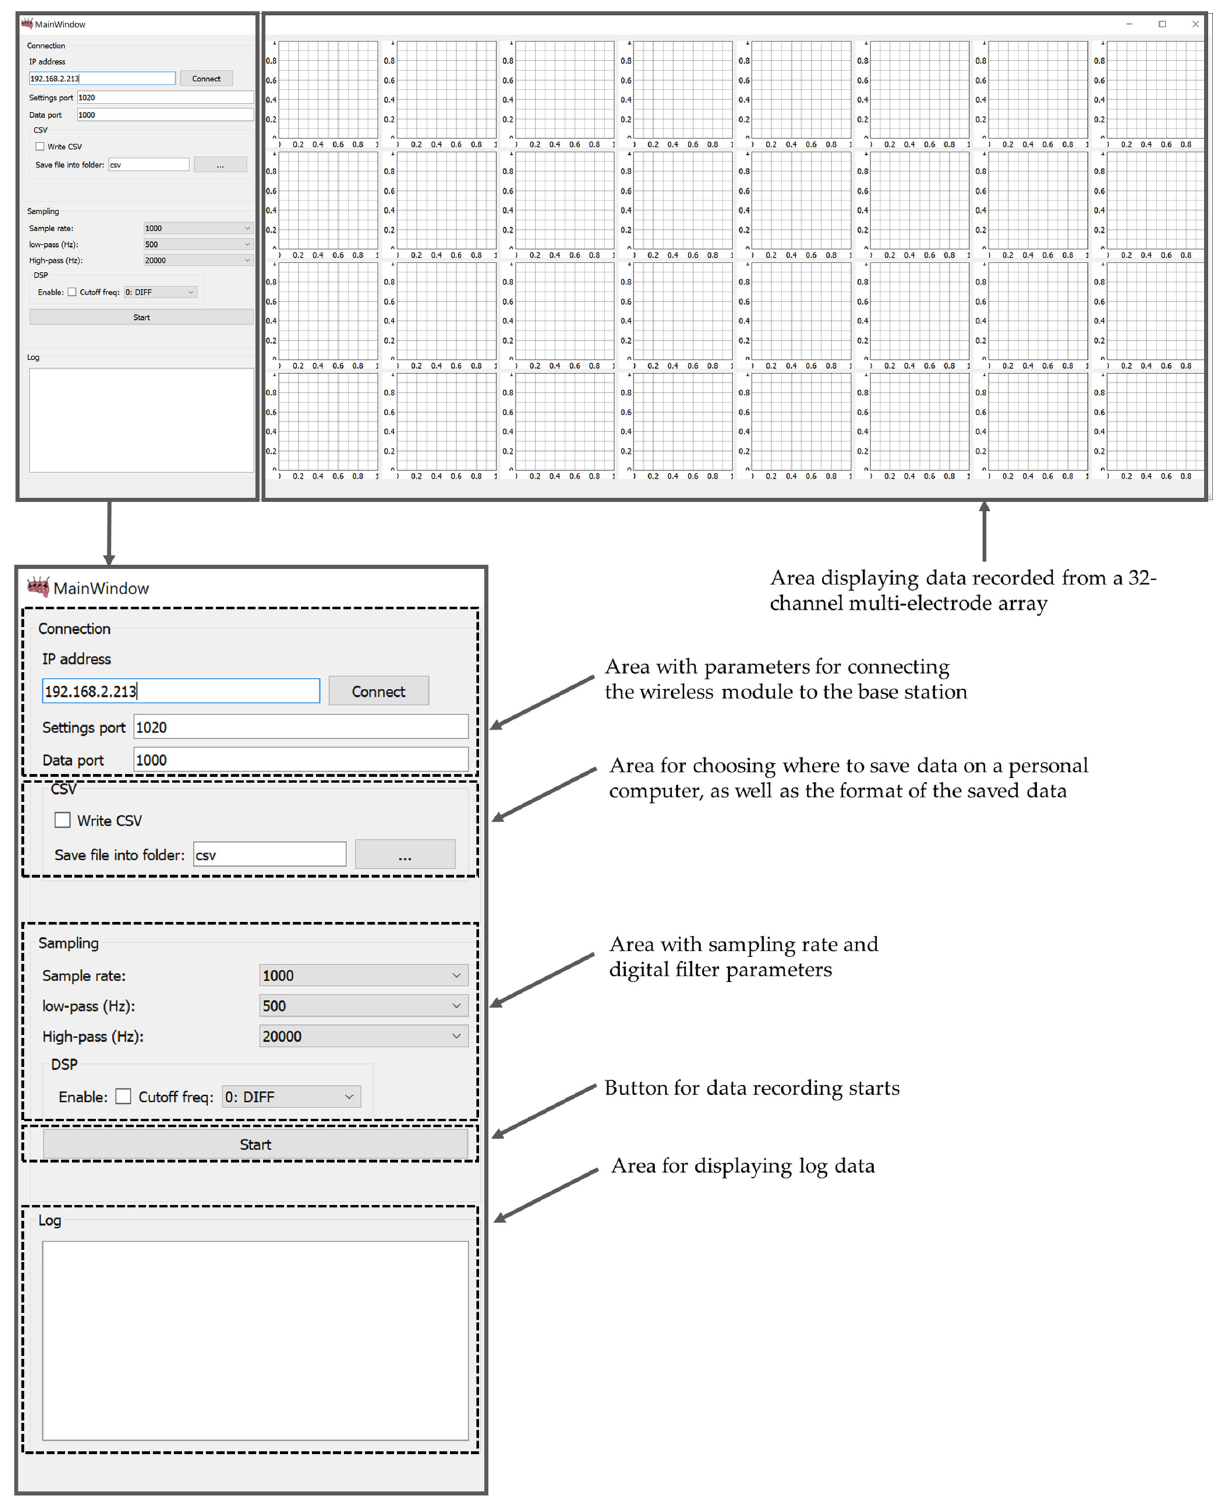
Figure 10. Data visualization and recording software GUI (MouseBrainView, 0.2.3).